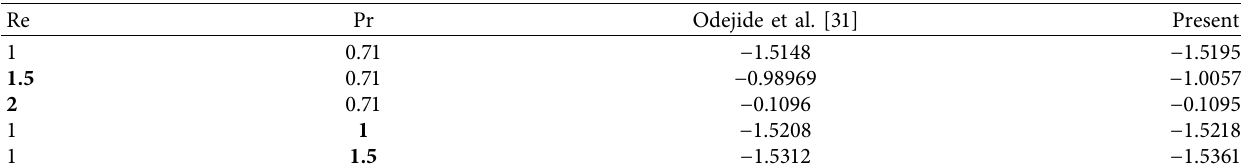
Table 4: Nusselt number for various values of Re and